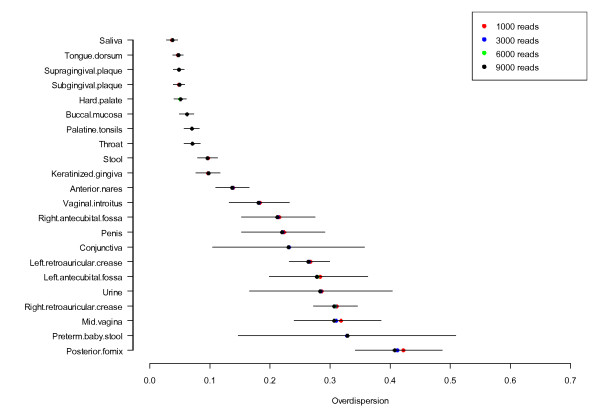
Bacterial community variation. Overall the variation of bacterial community for each habitat was evaluated by the over-dispersion parameter theta (m ± sd) from the Dirichlet-multinomial model. Higher theta indicates higher variation and vice versa. The variation within a bacterial community was calculated at 1,000, 3,000, 6,000, and 9,000 read depths as shown by different colors. No significant difference was found in bacterial community variation at different read depths.